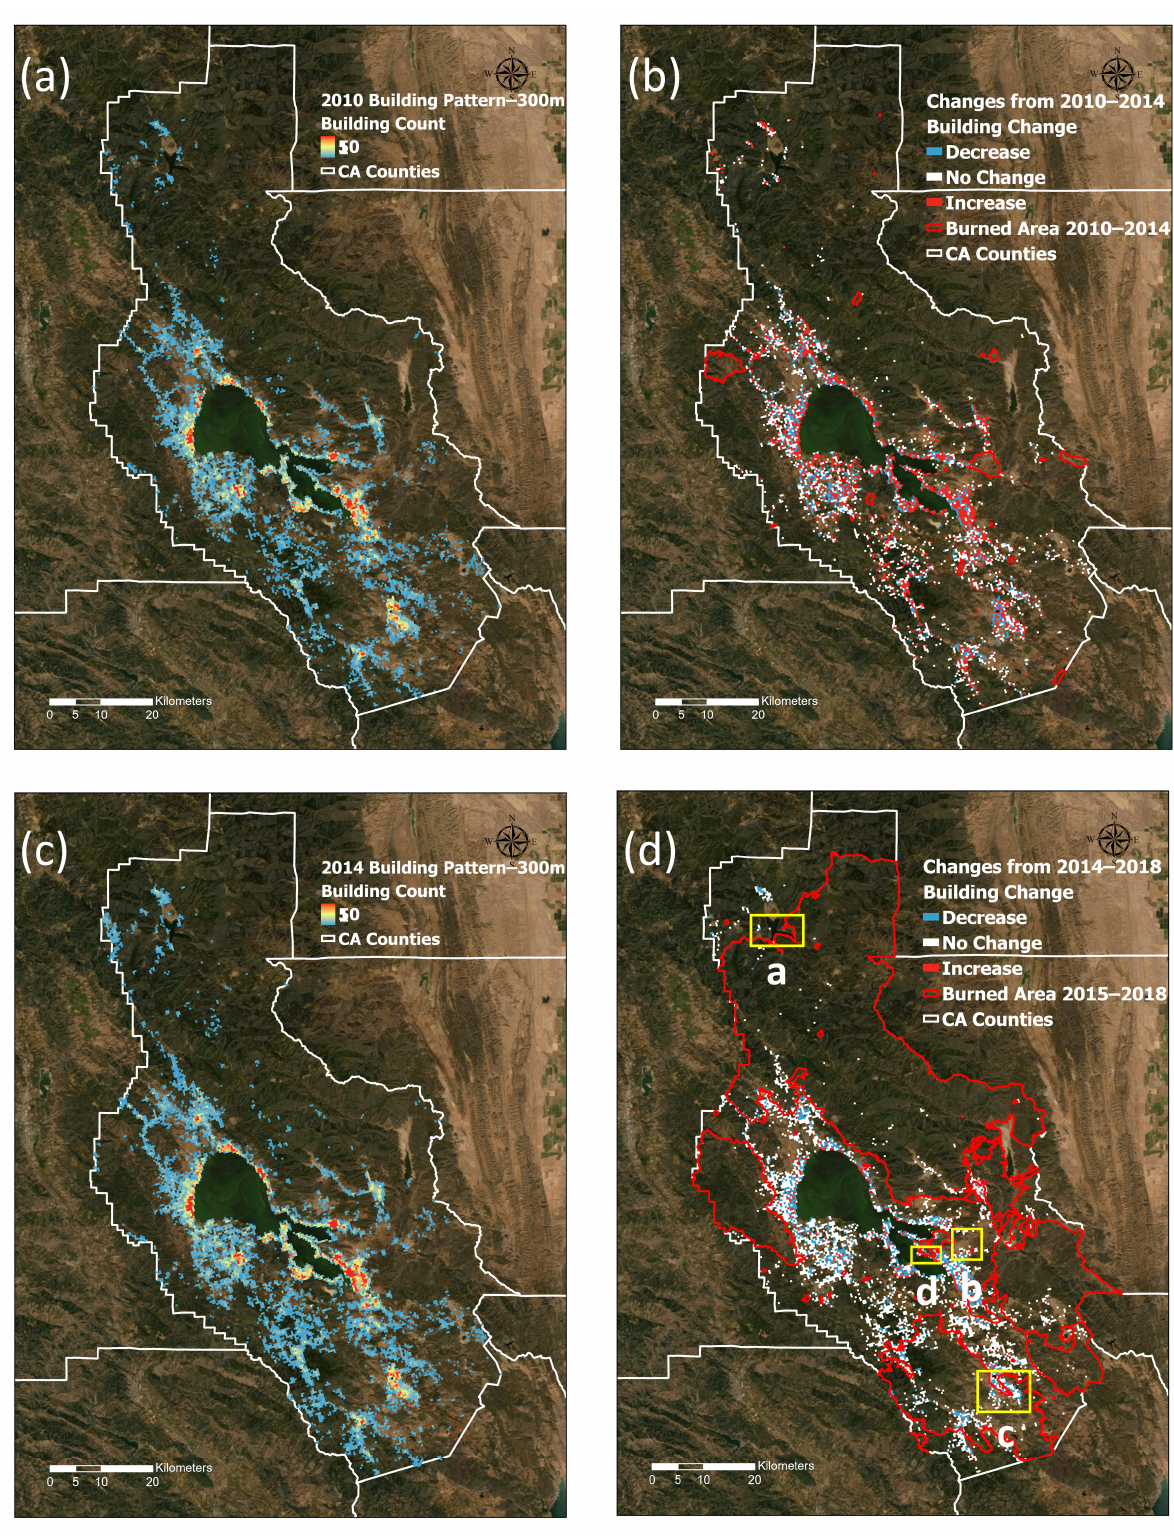
Figure 6. Spatial patterns of building counts in Lake County aggregated to 300 m resolution from building footprints identified from the NAIP imagery in ( a ) 2010 and ( c ) 2014. Changes in building counts are also shown from 2010 to 2014 ( b ) and from 2014 to 2018 ( d ), overlaid with wildfires burned during the corresponding periods. The yellow bounding boxes on Figure 6d indicate locations of example regions in Figure 7.